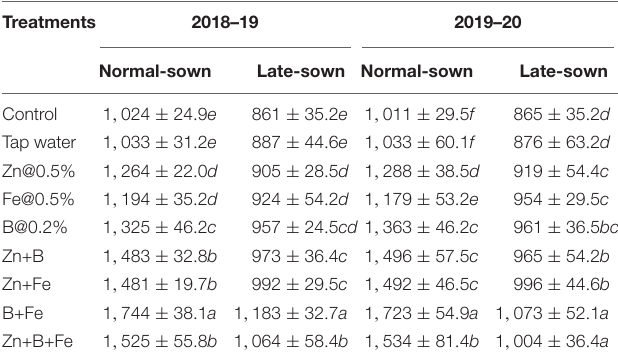
TABLE 7 | Effect of sowing time and zinc, iron, and boron foliar sprays on seed yield (kg ha − 1 ).